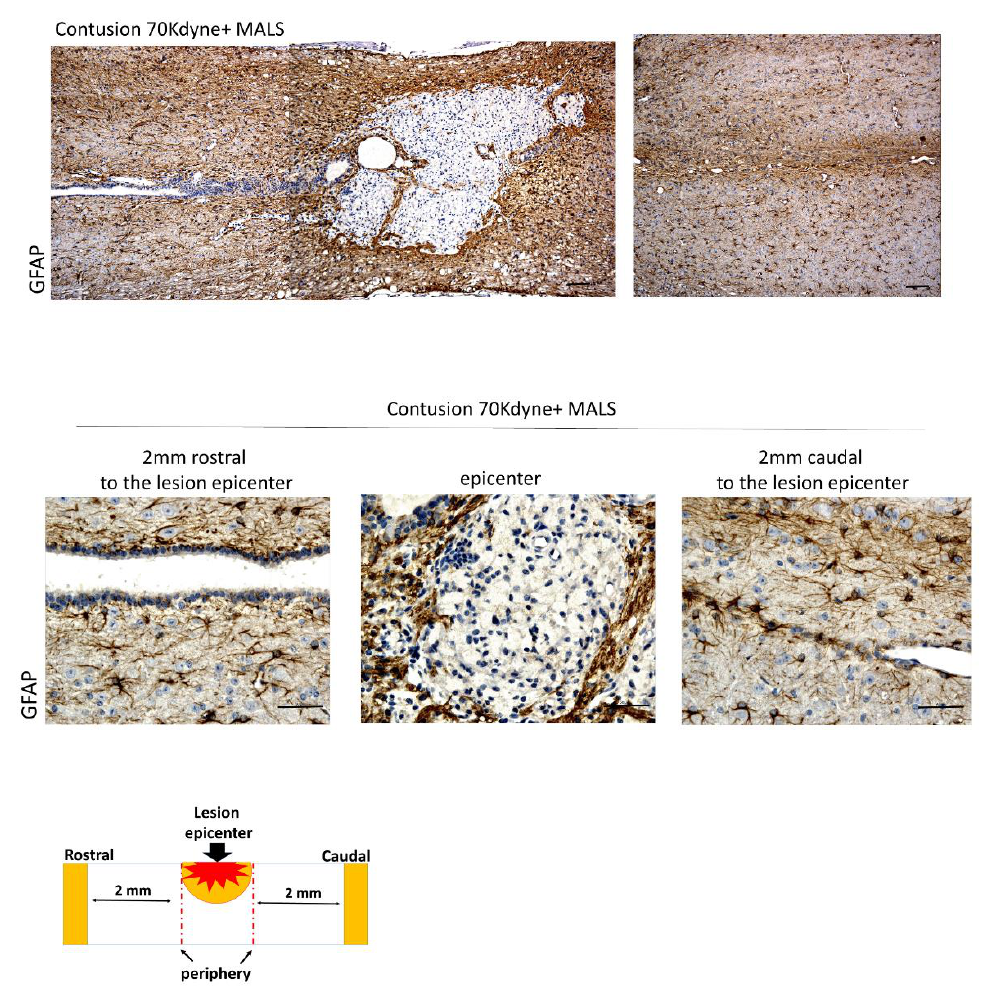
Figure 10. Glial scarring at the lesion site. The epicenter of the lesion and the surrounding areas (2 mm rostral and 2 mm caudal) were evaluated for the presence of GFAP. This indicates an ongoing scarring process. Scale bar: 100 and 50 µm. (n = 4 mice; 2 sections/mouse; 3 fields/section).